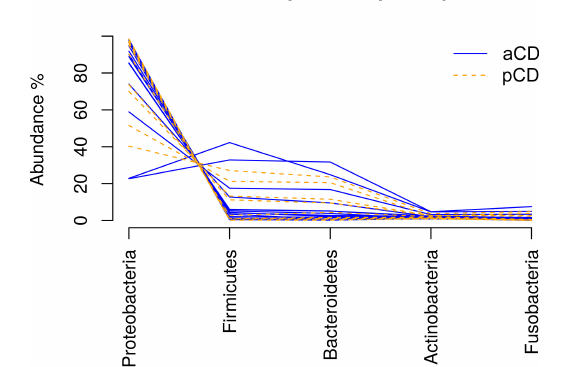
FIGURE1 Taxonomic composition of aCD and pCD patients’ microbiota Coordinate plot showing the relative abundance of the five most abundant phyla in each aCD and pCD duodenal